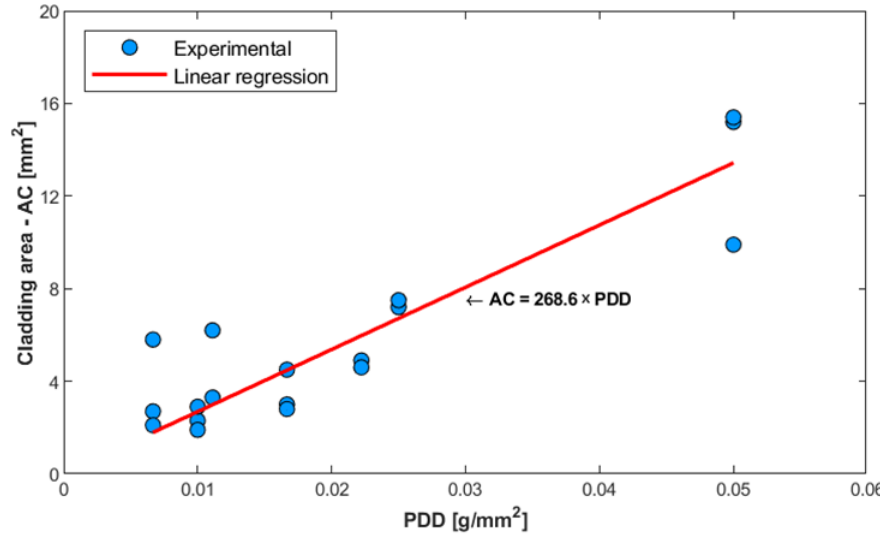
Figure 4. Dependence of cladding area on the value of the PDD complex parameter.